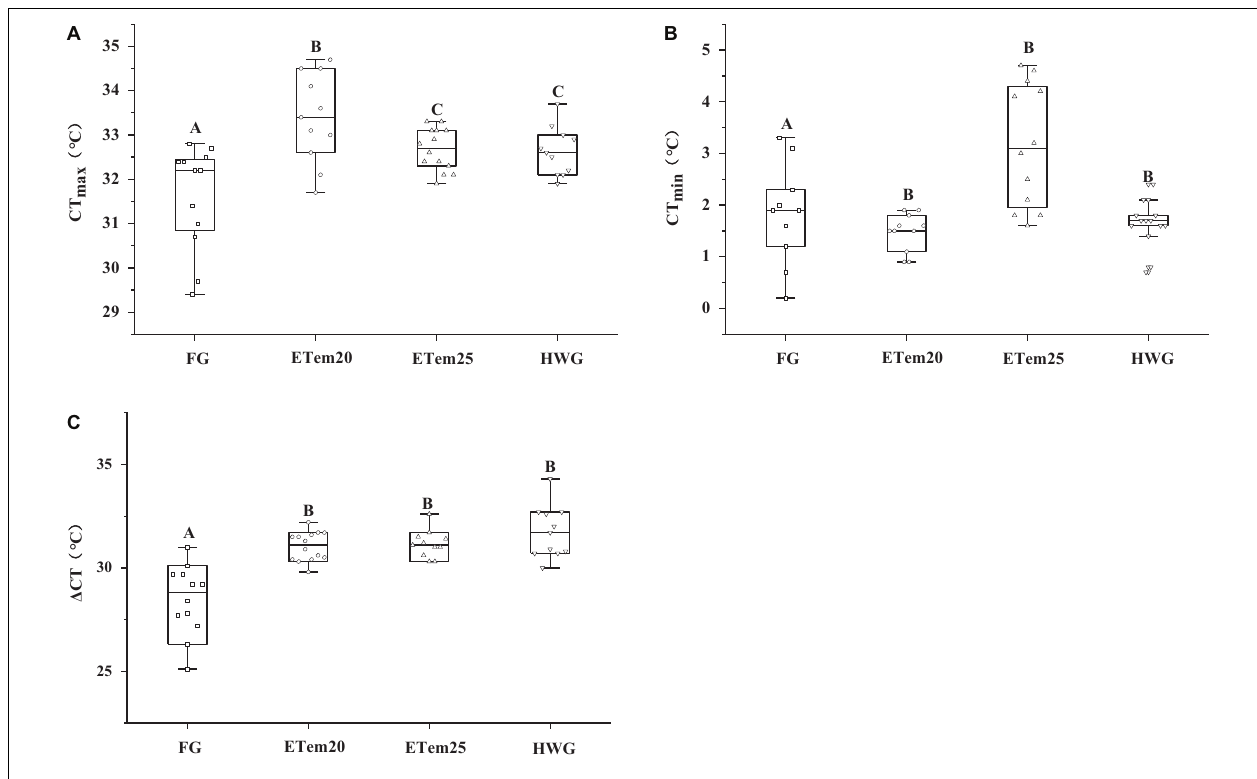
FIGURE 3 | Comparison of (A) critical thermal maximum (CT max ), (B) critical thermal minimum (CT min ), and (C) thermal tolerance range ( (cid:49) CT) of N. pleskei ( n = 13) in different temperature acclimation groups and field group. The significant difference was shown by comparing all the groups. Different characters mean P < 0.05. TABLE 2 | Stamina and burst swimming performance comparison of N. pleskei in different temperature acclimation groups and field group. N The total distance to exhaustion(cm) The total time to exhaustion(s) Burst swimming speed(cm/s) 1422.7 ±